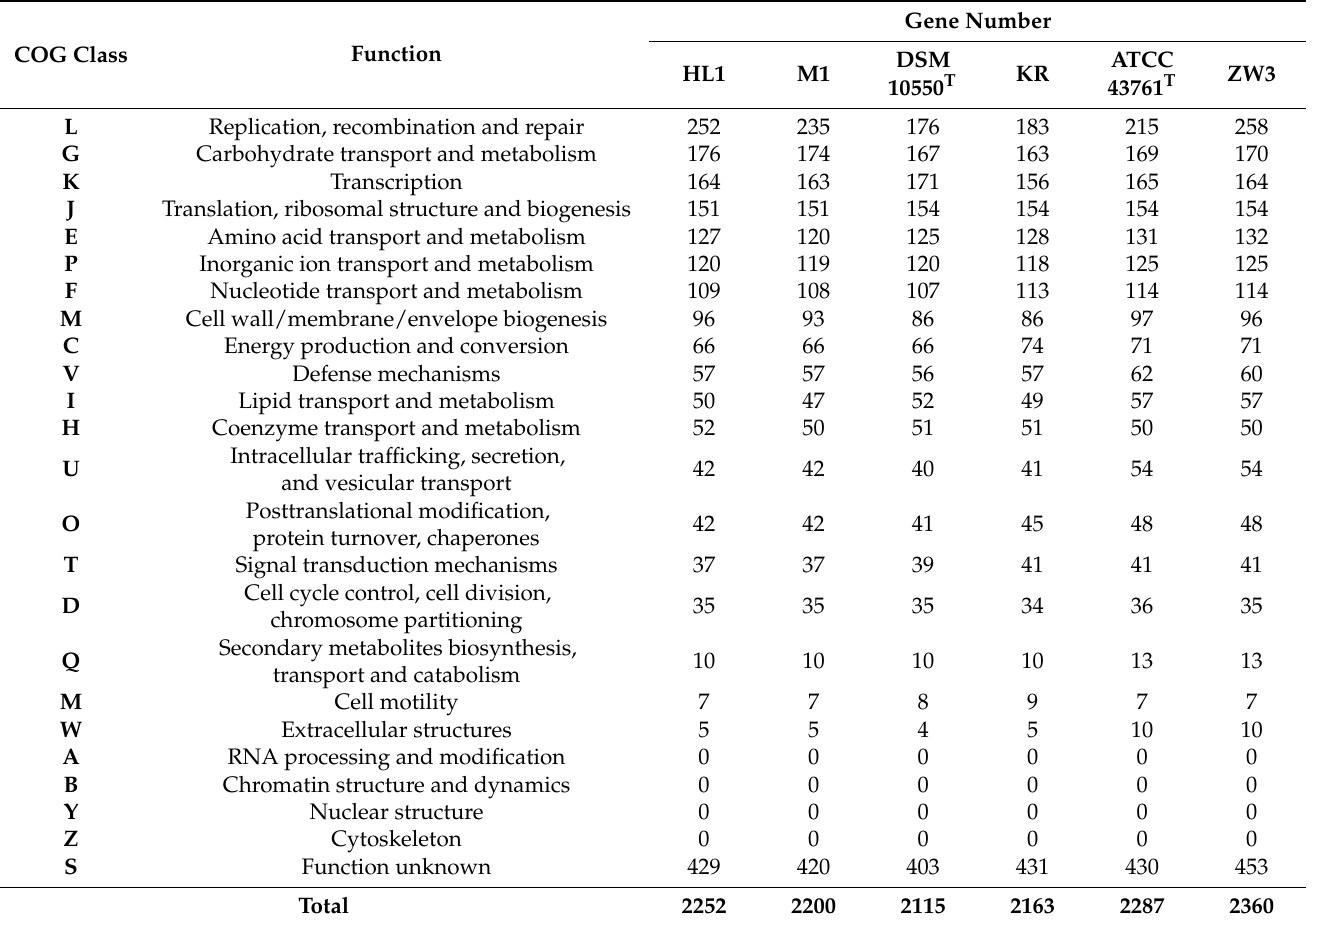
Table 3. Cluster of orthologous group categories (COGs) of Lactobacillus kefiranofaciens